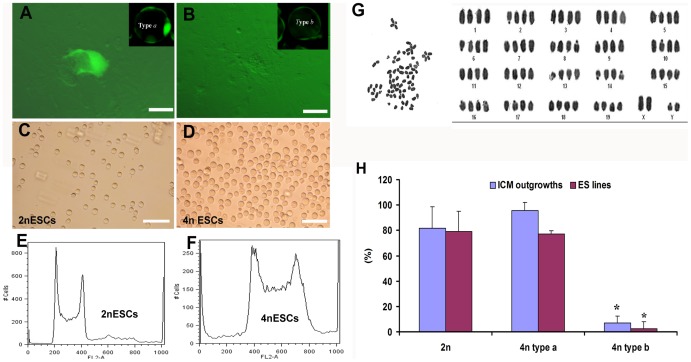
Embryonic stem cell (ESC) lines derived from type a 4n blastocysts.(A) Inner cell mass (ICM) outgrowth on MEFs from a type a Oct4-EGFP 4n blastocyst at the 4th day of culture in ESDM. (B) An embryonic remnant from a type b 4n blastocyst at the 4th day of culture in ESDM. (C, D) ESCs derived from both 2n embryos and type a 4n embryos. Note the larger cell size for 4nESCs (D) than 2nESCs (C). (E) Karyotype of 4nESCs (4n = 80). (F) Efficiency of ESC line derivation for 4n blastocysts from Oct4-EGFP mouse strain. The efficiency of ESC derivation for type a 4n blastocysts is similar to that for 2n blastocysts, while the efficiency for type b 4n blastocysts is significantly decreased (P<0.01). The type a and type b embryos were identified by visualization of the Oct4-EGFP under the fluorescence microscope.